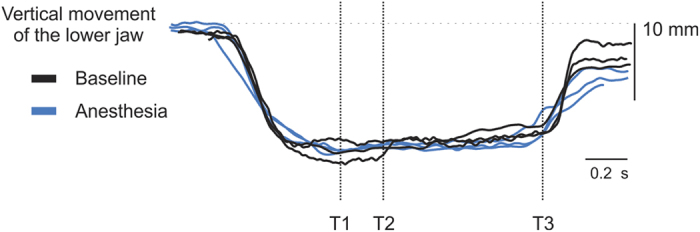
Representative recordings of vertical jaw movement when performing the “manipulation and split” task by three participants in the experimental group at baseline (intact sensory information) and the same participant’s during intervention (no sensory information due to anaesthesia). Notice the similar duration and jaw movement behaviour for the six vertical traces.